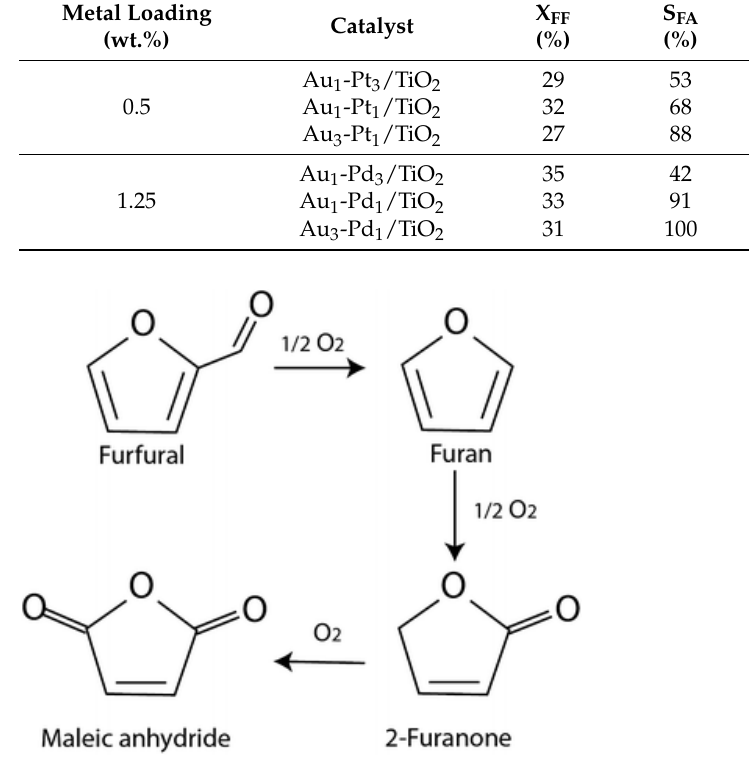
Figure 7. Reaction pathway for the formation of maleic anhydride from FF through FAO [22]. For comparing the effect of each metal, the two catalysts (2% Au 3 Pt 1 and 2% Au 3 Pd 1 ) were chosen. The results showed that the Pt-based catalyst was able to convert 64% of FF after 4 h with a 6% yield of MA, while only 32% of the conversion was obtained using the Au-Pd catalyst with no formation of MA. However, the selectivity to FA reached 100% with the Au-Pd catalyst instead of 60% for the Au-Pt sample. Both Pd and Pt in the bimetallic catalyst produced furoic acid as a major product. These results further demonstrate that 2% Au 3 Pd 1 /TiO 2 is a promising catalyst for the base-free aerobic oxidation of FF to FA in water. It could also be seen that with the Au-Pt catalysts the maximum yield of MA (8%) was achieved using the 2% Au 1 -Pt 1 /TiO 2 catalyst while only 1.6% was achieved using the 2% Au 1 -Pd 1 /TiO 2 catalyst. It seems that the reaction temperature strongly affects the catalytic properties of the Au-Pt and Au-Pd nanoparticles, whereby each catalyst behaved differently during the oxidation of FF. Therefore, when performing the same tests at 110 °C, a full conversion (100%) of furfural was observed. However, no products were de- tected using the Au-Pt based catalysts, with a very low carbon balance (in some cases reaching 0%). This indicates the overoxidation of the furfural and the formation of low molecular weight molecules or condensation products (via the ring opening reaction and the formation of maleic acid). Regarding the Au-Pd-based catalysts, a maximum yield of MA (14%) and (5%) of FAO was obtained using the 2% Au 1 -Pd 1 /TiO 2 catalyst at 110 °C, while the carbon balance was very low with a complete conversion of FF, also indicating the overoxidation and the degradation of FF, but at a lower extent when compared to the Au-Pt catalyst. It was previously reported that the overoxidation and the poisoning from byproducts could be responsible for the deactivation of Pd- or Pt-based catalysts when they are used in the liquid phase with oxygen as an oxidant [23]. By comparing the mon- ometallic Au-, Pt-, and Pd-based catalysts to the bimetallic catalysts, the monometallic catalysts were by far less active than the bimetallic catalysts in terms of furfural conver- sion, and the formation of FA, MA, and FAO intermediates. From a functional point of view, it is important to state that better catalytic performances could be obtained with the highly active bimetallic catalysts than with the gold-based monometallic catalysts when working under certain conditions (such as 80 °C, air as oxidant) and with specific chemical compositions (such as Au-Pd and Au-Pt). A good correlation appeared between the per- formances of these catalysts, and in the chemical composition and the loading of both metals. The nature of the second metal (Pd or Pt) which mainly governs the catalytic ac- tivity seems to also have a strong impact on the oxidation in base-free conditions. Rela- tively high yields of MA observed for the Au-Pd catalysts indicate a radical mechanism of the reaction which favors the ring opening pathway. The recyclability of the Au/TiO 2 catalyst was also studied. The recycling tests were performed using the same methodology as described in the Experimental Part. The